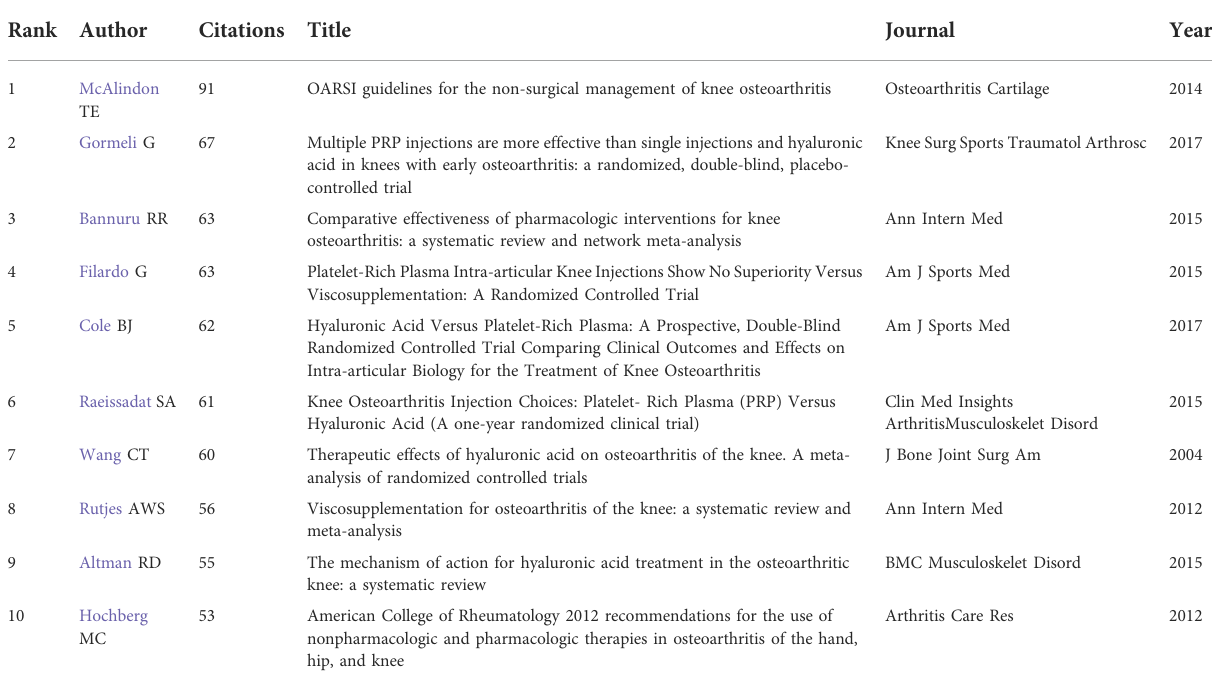
TABLE 5 The top 10 co-cited references related to HA for the treatment of